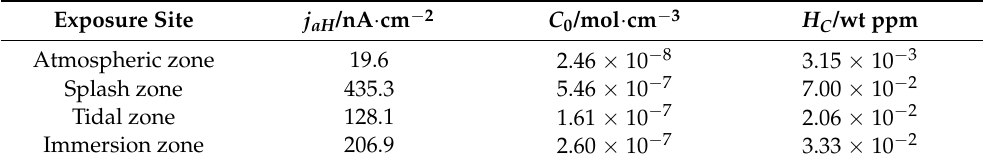
Table 2. The parameters for hydrogen permeation of AISI 4135 steel in different marine corrosion zones, including the average hydrogen permeation current density ( j aH ), sub-surface hydrogen concentration ( C 0 ), and diffusible hydrogen content ( H C